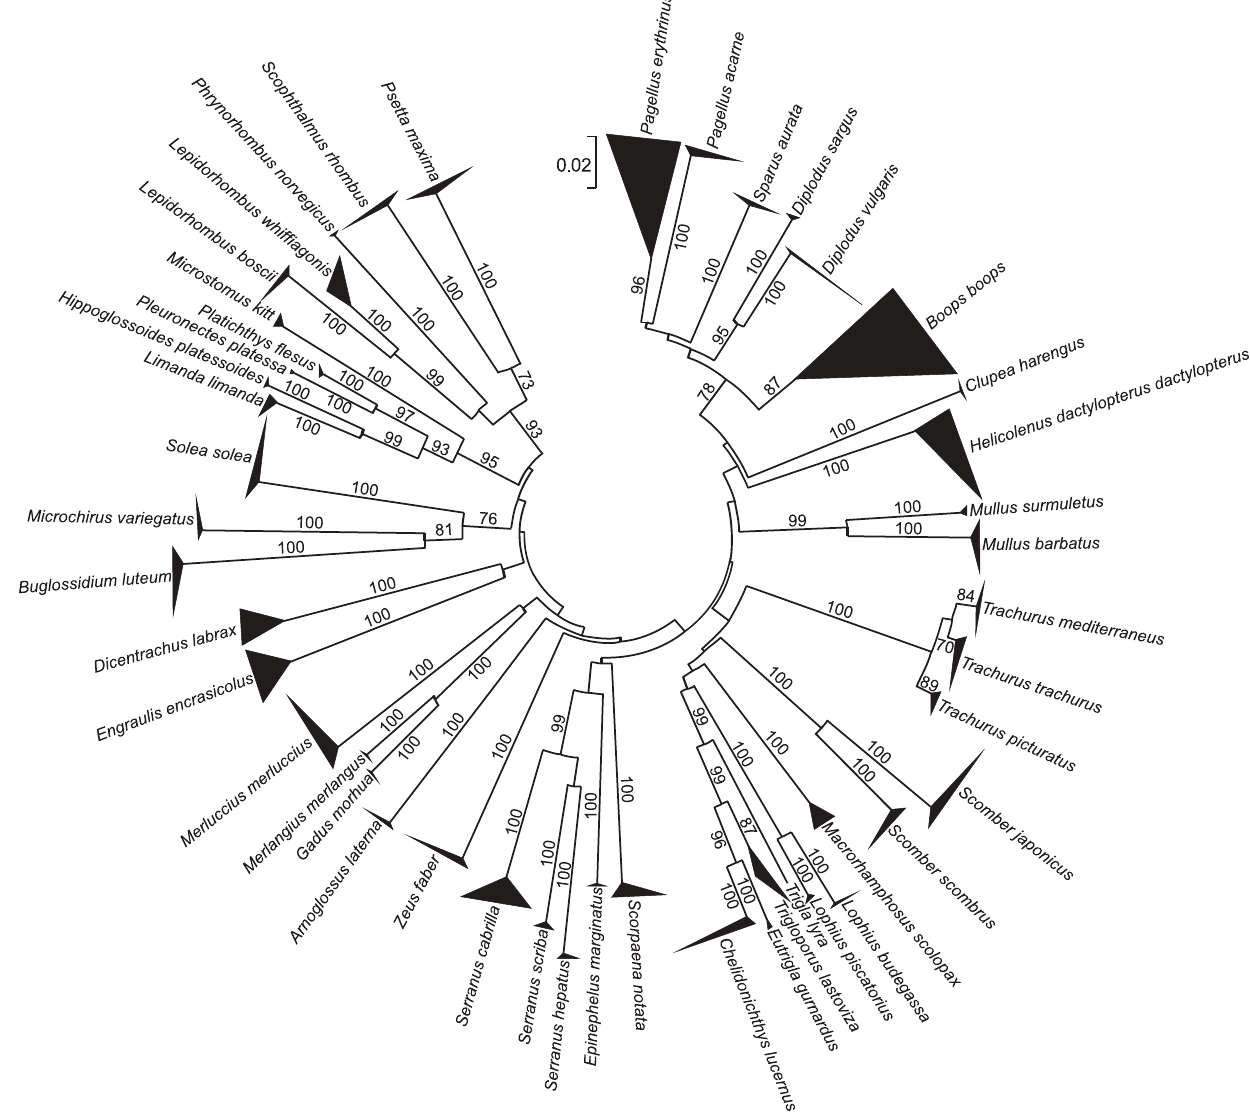
Figure 5. Phylogenetic analysis (COI). Neighbour Joining tree for partial sequences of the mitochondrial cytochrome oxidase subunit I gene of fishes from European seas. The number of sequences and their geographic origin for each species are given in Table 1 and Supporting Information Table S1. Bootstrap values based on 1000 replicates are indicated at branches.